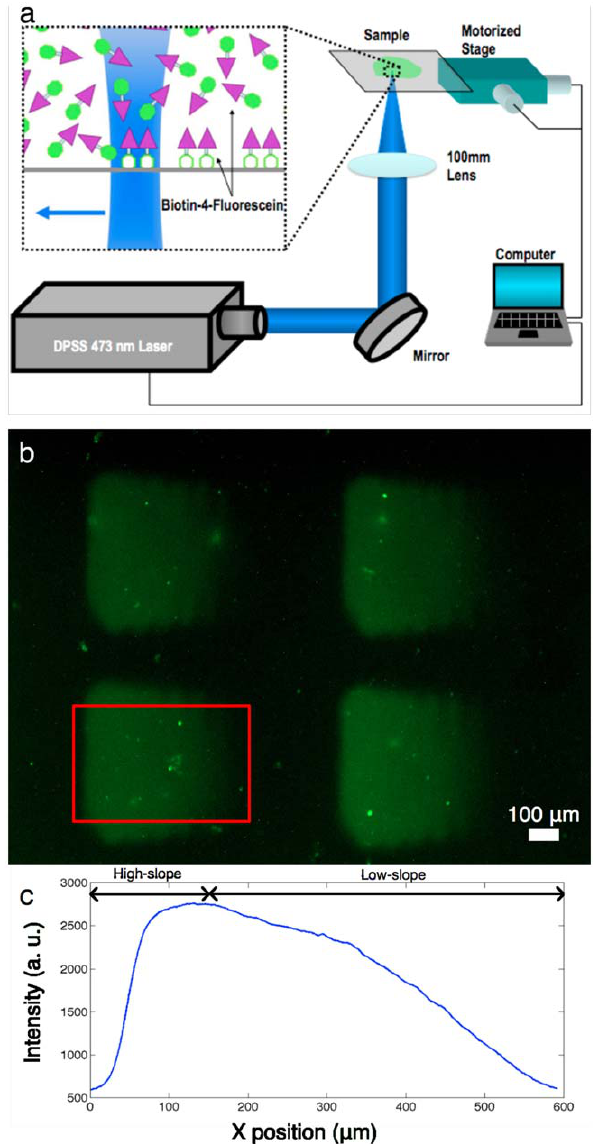
Figure 1. Patterns of laminin-1 produced using LAPAP. (a) The platform consists of a 473 nm diode-pumped solid-state laser, a lens and a 3-axis motorized stage to produce the desired patterns of biotin- 4-fluorescein. (b) Large gradients (400 m m 6 600 m m) of laminin-1 were fabricated by sequentially incubating streptavidin-DyLight549, biotiny- lated goat anti-rabbit IgG (Fc specific), rabbit anti-laminin-1 and laminin-1. This particular pattern was imaged using chicken anti- laminin-1 and Cy5 goat anti-chicken IgG to reveal the presence of laminin-1. The red rectangle delimits the section of the patterns considered for the RGC-5 guidance assay. (c) x-direction mean profile of 25 gradients. The first quartile (on the left) of the pattern was used as a high-slope gradient while the last three quartiles (on the right) were used as a low-slope gradient.